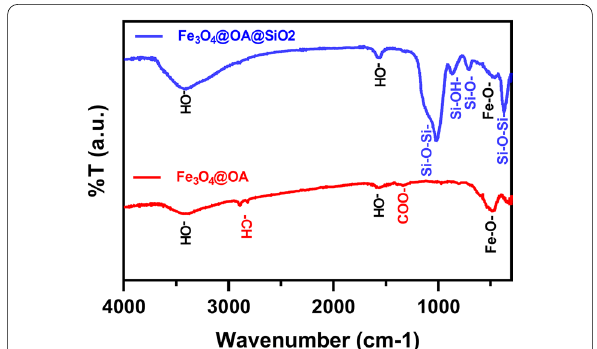
Fig. 4 The FTIR spectra. ( A ) Fe 3 O 4 @OA. ( B ) Fe 3 O 4 @OA@SiO 2